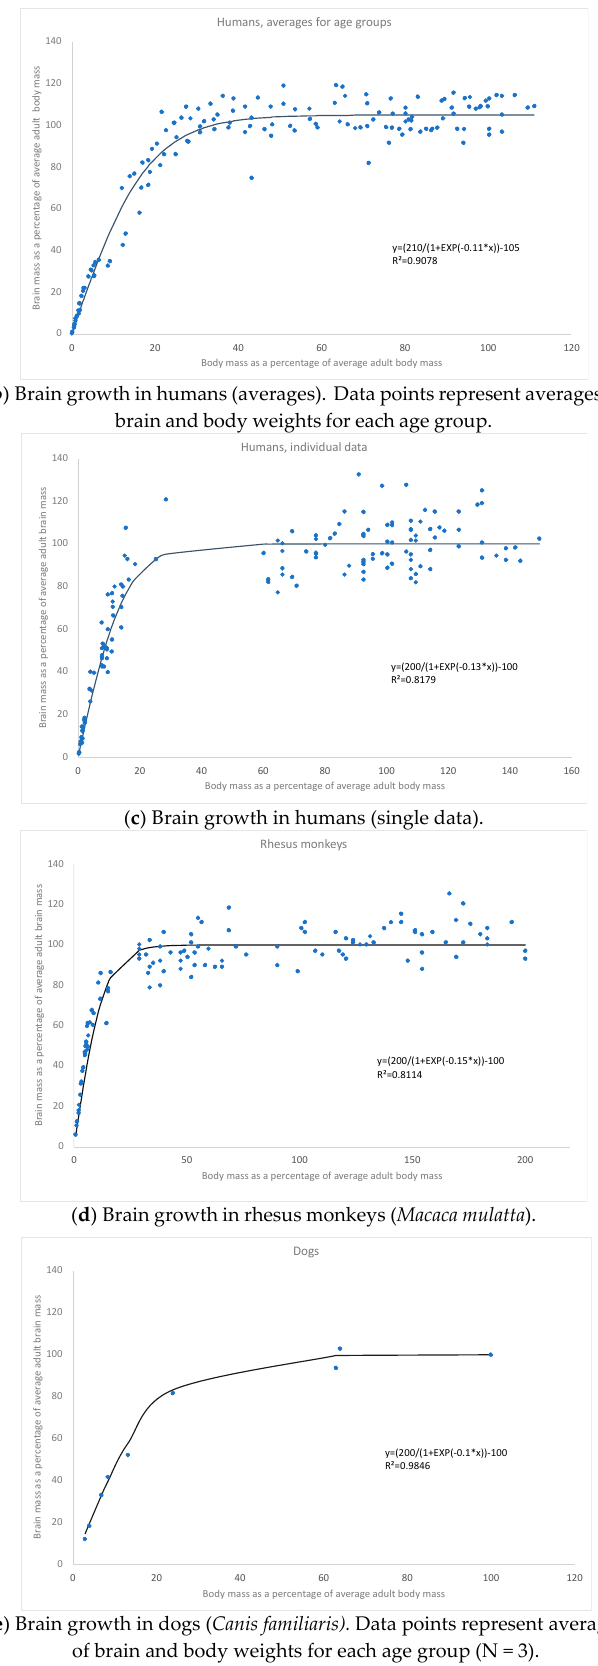
Humans, averages for age groups